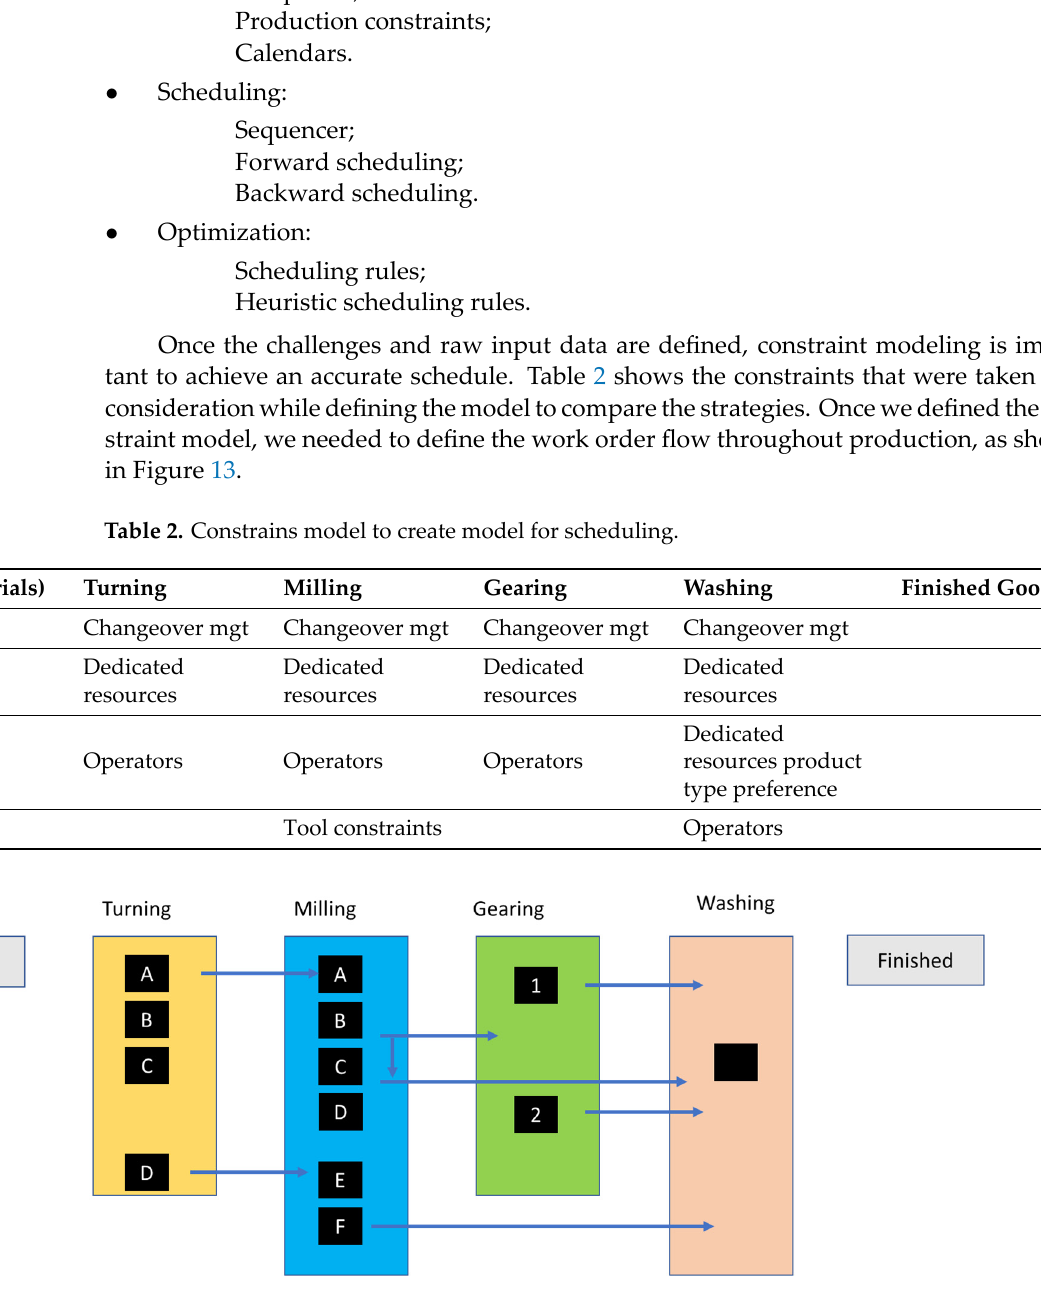
Figure 14. Zero-defect Manufacturing classical architecture extended by IIoT and Advance sched- uling.